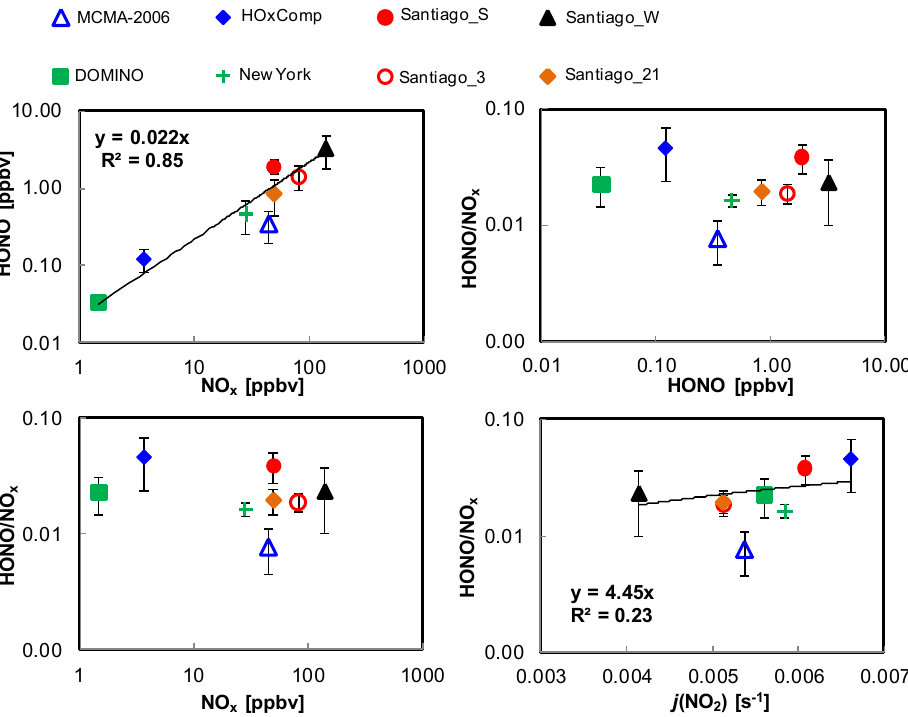
Fig. 6. Correlations between HONO, NO x and j (NO 2 ) daytime average values for different measurement campaigns. Error bars represent 1 σ of the mean.